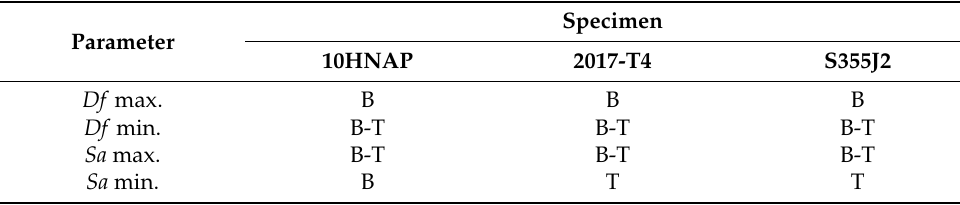
Table 4. Extremum values of topography parameters for total fracture area.